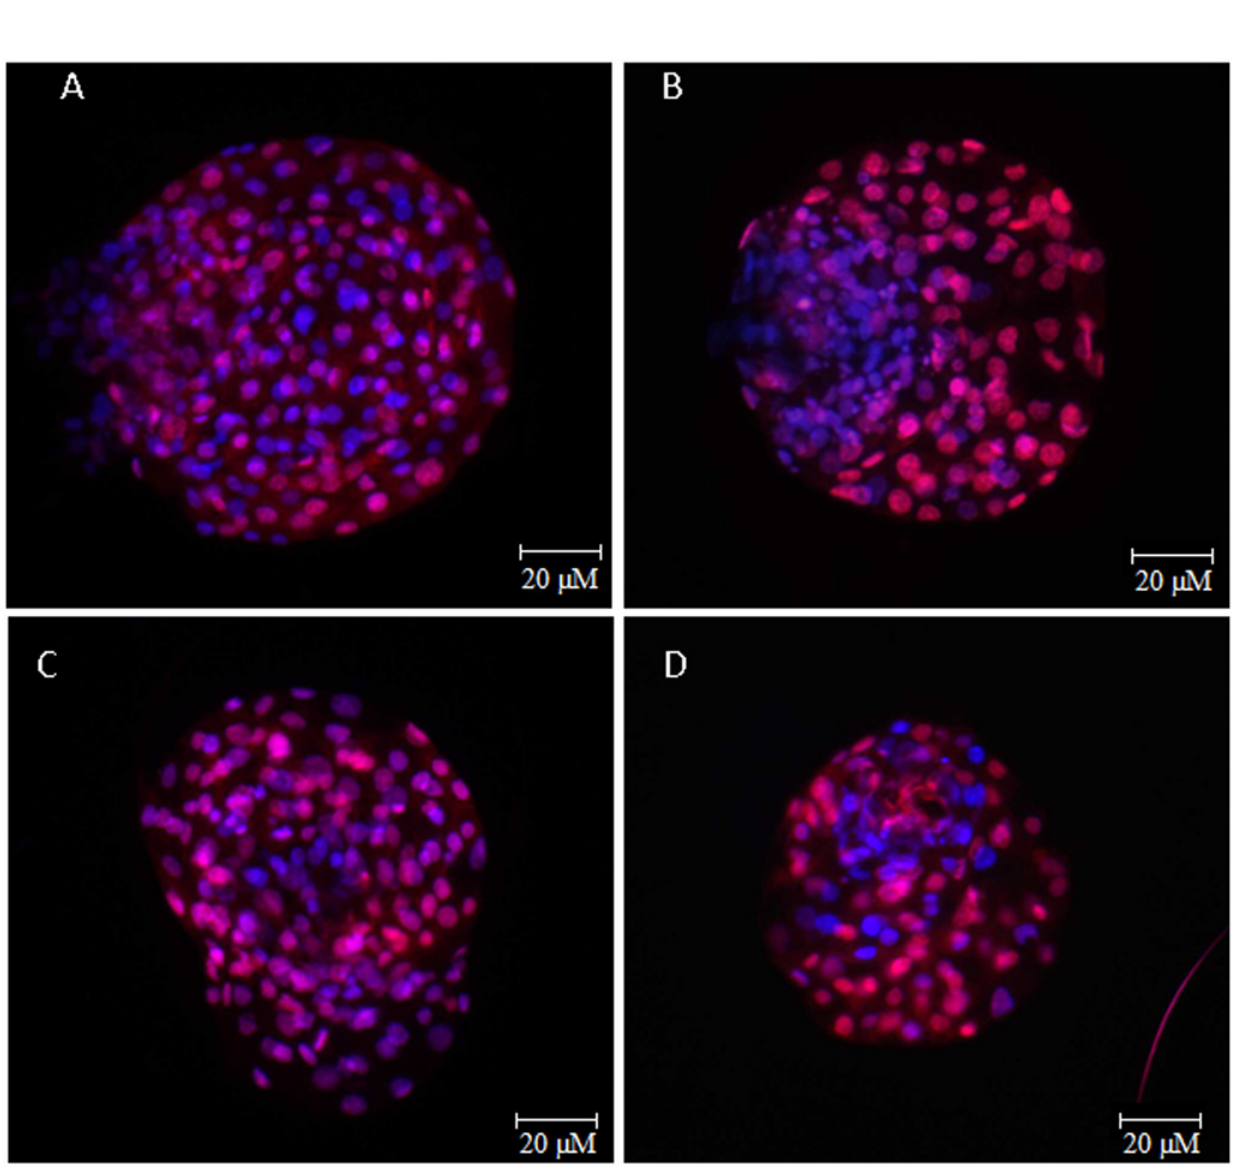
Fig 2. Differential staining by fluorochrome. Epifluorescence photomicrography of the differential staining by fluorochrome of hatched blastocysts cultured with two sources of protein and classified according to the speed of development: A) Fast developing embryo cultured with BSA; B) Slow developing embryo cultured with BSA; C) Fast developing embryo cultured with FCS; and D) Slow developing embryo cultured with FCS.